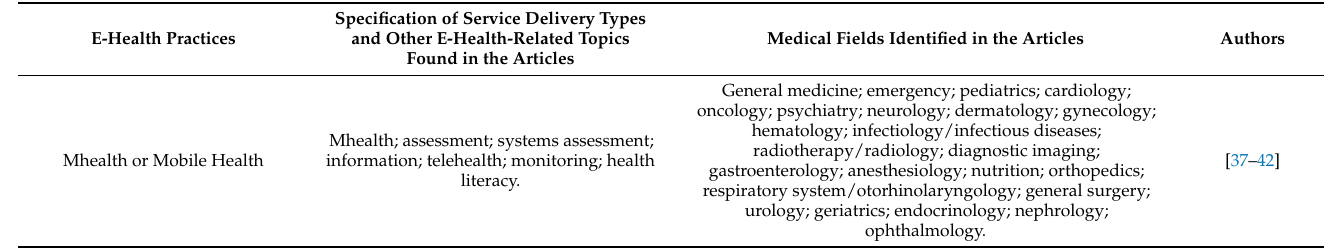
Table 2. E-health practices and